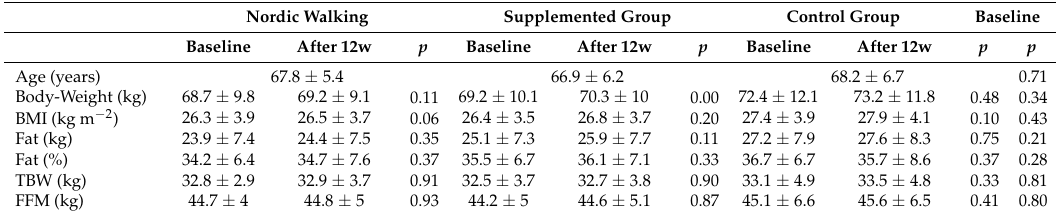
Table 1. Characteristics of the participants before and after the applied procedure. Nordic